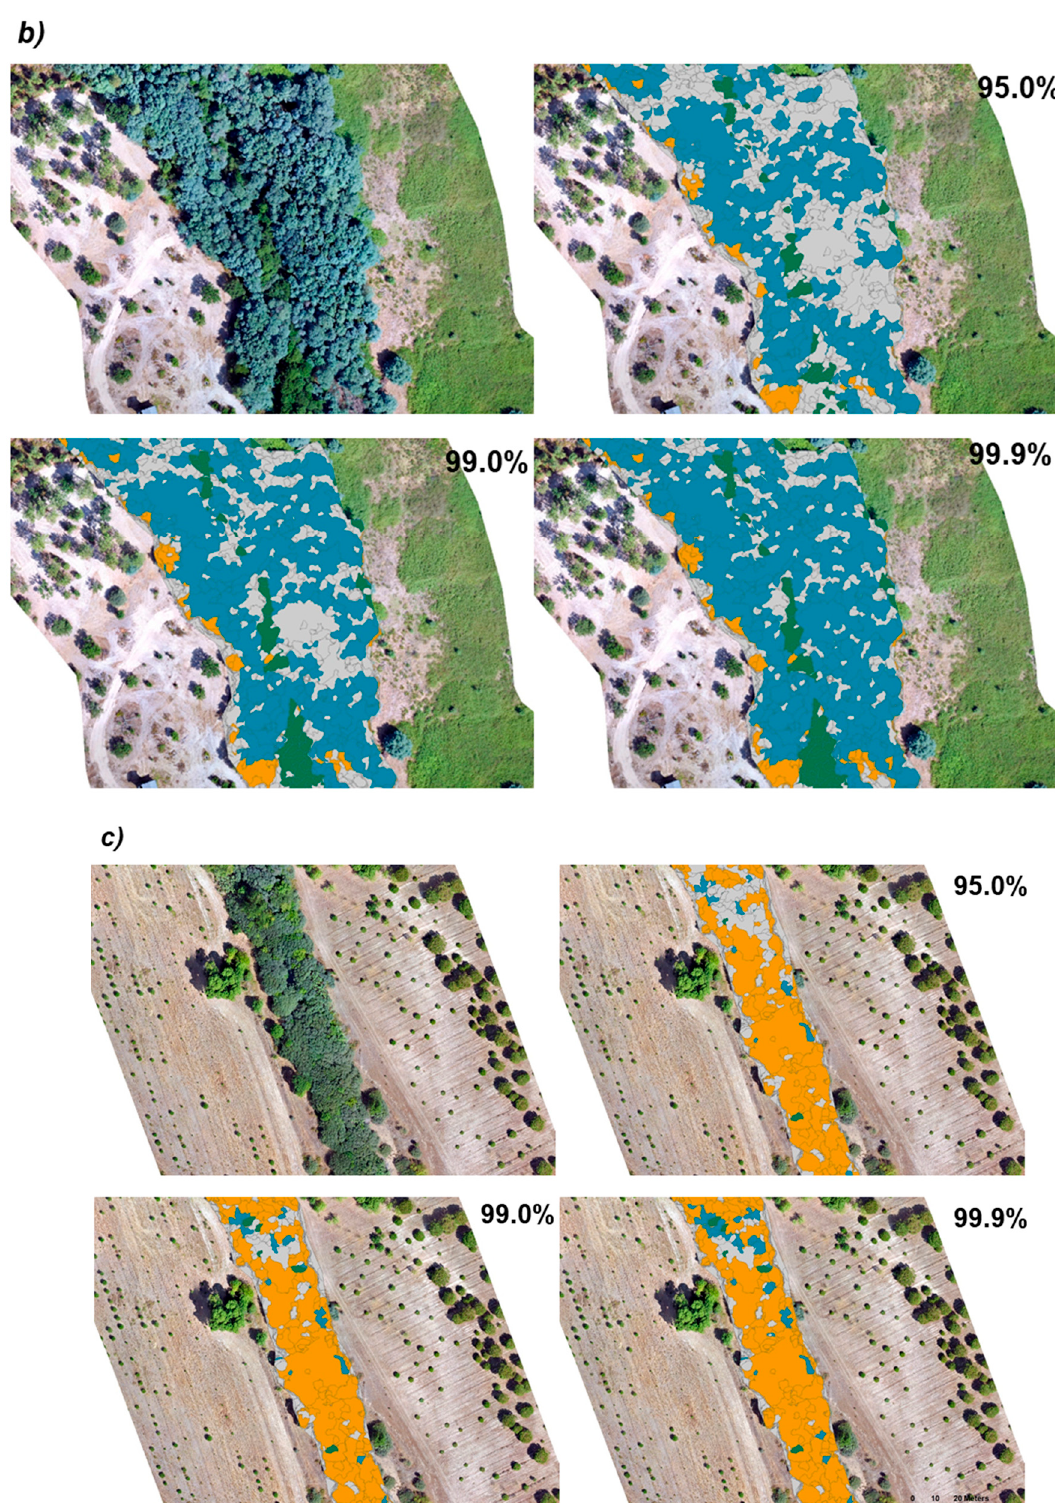
Figure 6. Illustration of results using True-color (RGB) composite UAV imagery (top left panels) and classified object-based maps in an illustrative area located in: ( a ) the northern part of the riparian forest dominated by Alnus glutinosa , ( b ) the central part of the riparian forest dominated by Acacia dealbata and ( c ) the southern part of the riparian forest dominated by Salix salviifolia . Green patches represent Alnus glutinosa classified objects, blue patches represent Acacia dealbata classified objects, yellow patches represent Salix salviifolia classified objects and grey patches represent unclassified objects according to 95%, 99% and 99.9% regions of probability.